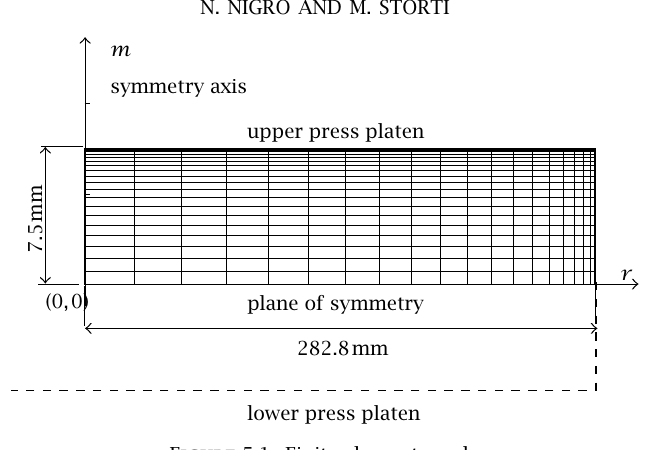
Figure 5.1 . Finite element mesh.